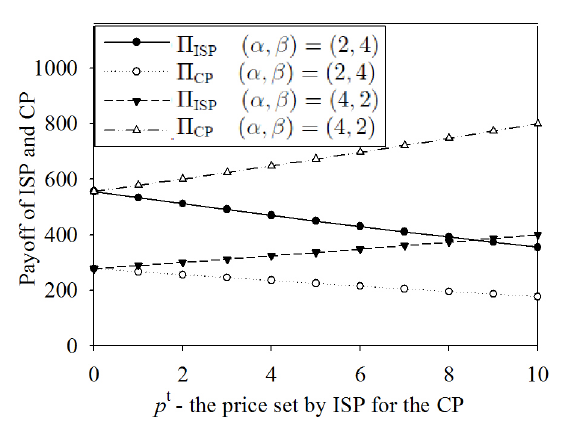
Figure 3: NE point prices of ISP and CP.